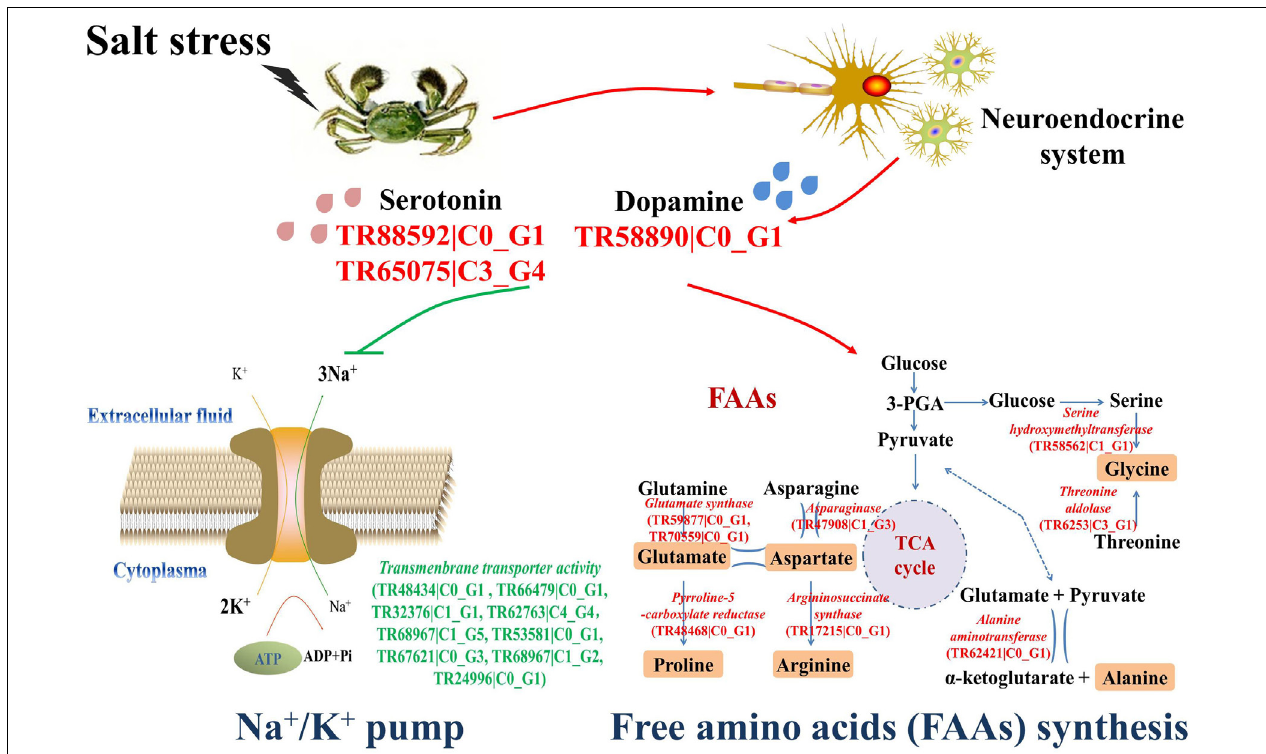
FIGURE 4 | The osmoregulatory pathways in the hemocytes of Chinese mitten crab. The significantly up-regulated genes were shown in green letters, and the significantly up-regulated genes were shown in red